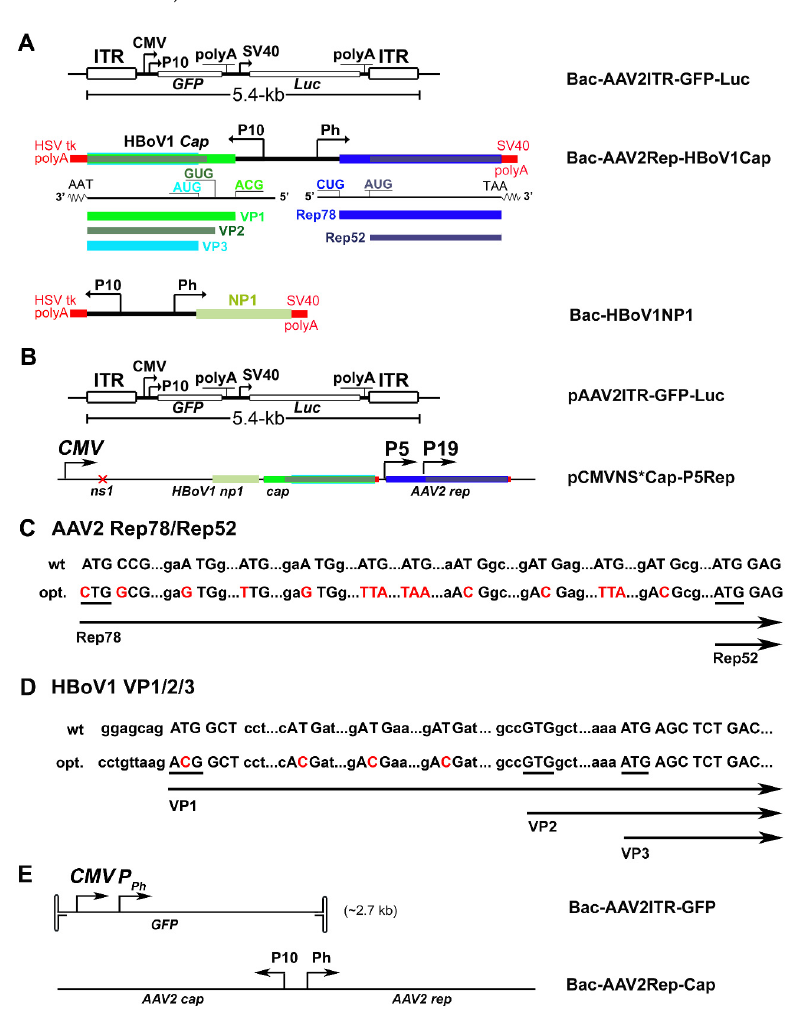
Figure 1. Construction of baculoviral transfer plasmids for vector production in Sf9 cells and the plasmids for rAAV2 / HBoV1 vector production in HEK293 cells. ( A ) BEVs for rAAV2 / HBoV1 production. Schematically diagrammed are structures inside the BEVs that were involved in rAAV2 / HBoV1 production. Bac-AAV2ITR-GFP-Luc carries an rAAV2 genome of 5.4-kb; Bac-AAV2Rep-HBoV1Cap expresses AAV2 Rep proteins and HBoV1 capsid proteins as shown; and Bac-HBoV1NP1 expresses HBoV1 NP1. P10 and Ph are baculoviral promoters, and CMV and SV40 are cytomegaloviral immediate early and SV40 virus early promoters, respectively. PolyA: polyadenylation signal; Luc: firefly luciferase. ( B ) Plasmids used for vector production in HEK293 cells. pAAV2ITR-GFP-Luc carries the same rAAV2 genome as shown in panel A. pCMVNS*Cap-P5Cap is a two-in-one plasmid. It was derived from the plasmid pHBoV1CMVNS*Cap [28], in which the NS1 / 2 ORF was early terminated. An AAV2 P5 and P19 driven rep gene was cloned after the CMV promoter-driven HBoV1 cap gene expression cassette. ( C , D ) Codon optimization. Both wild type (wt) and optimized (opt.) sequences between ATGs of the AAV2 Rep78 and Rep52 ORFs ( C ) and of the HBoV1 VP1 and VP3 ORFs ( D ) are diagrammed. Nucleotides in red indicate mutations. ( E ) BEVs for rAAV2 production in Sf9 cells. Bac-AAV2ITR-GFP carries a GFP expression cassette under both the CMV and P10 promoters. Bac-AAV2Rep-Cap carries expression cassettes of AAV2 cap and AAV2 rep under the P10 and Ph promoters,